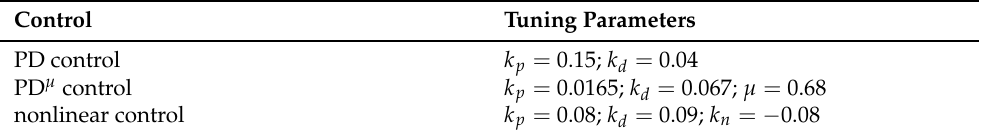
Table 2. Control tuning parameters.